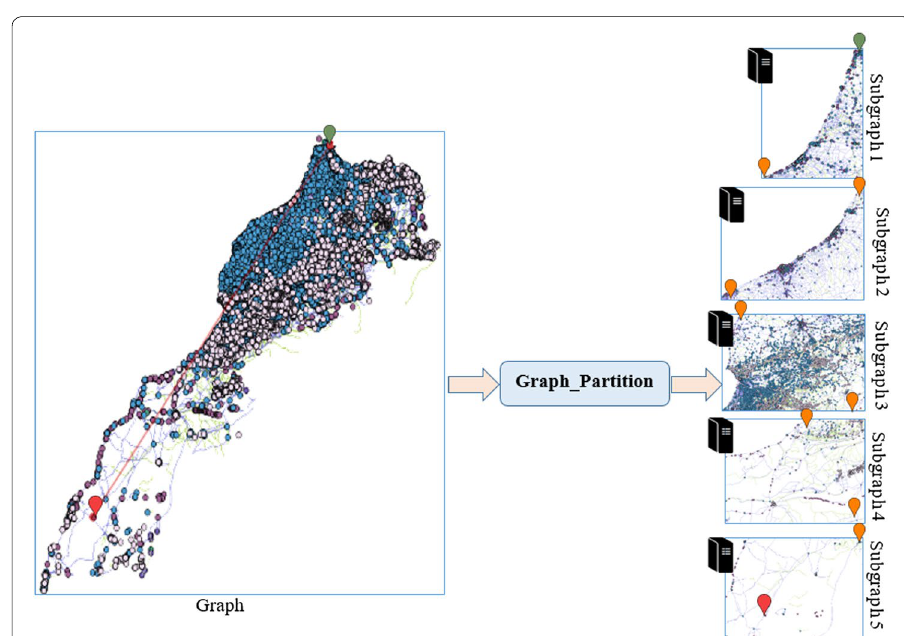
Fig. 7 Input stage: road network partitioning. The road network is split into five subgraphs. Each subgraph size is equal to 350